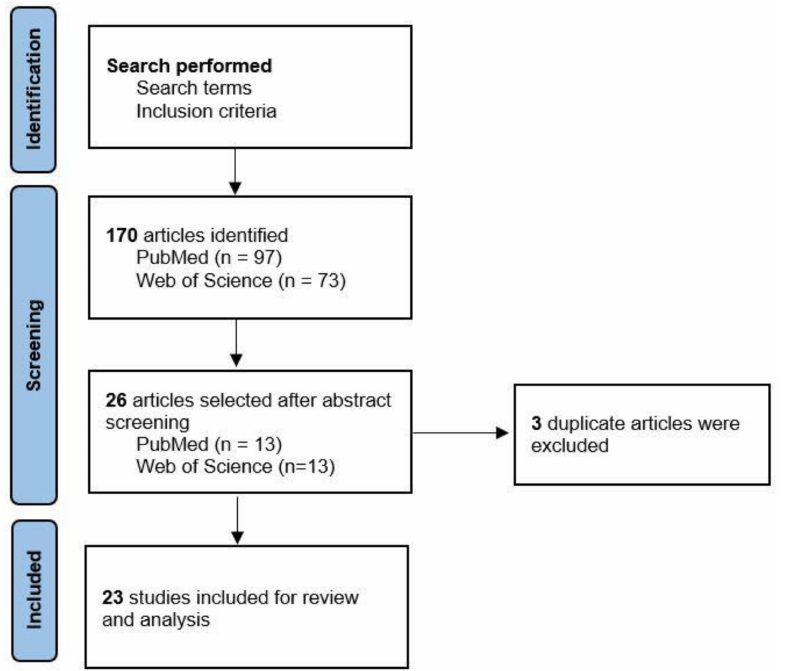
Figure 1. The literature search